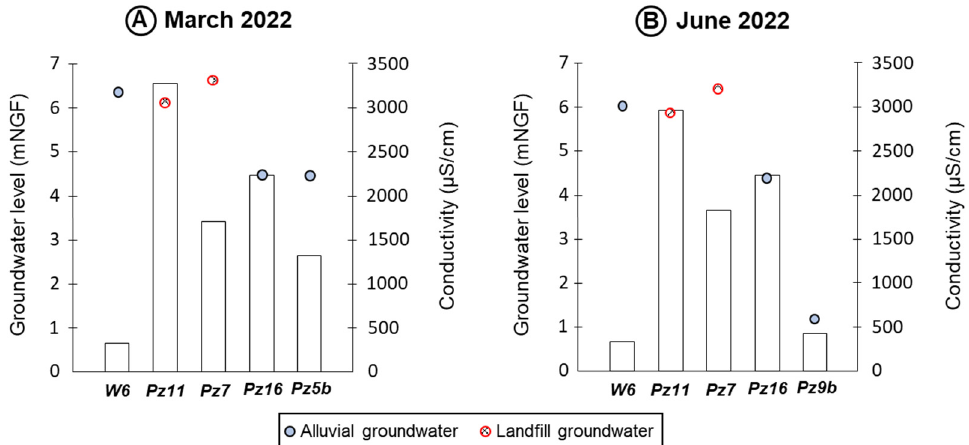
Figure 3. Water level (in m, dots) and conductivity (in µ S/cm) at the different sampling points from upstream to downstream in ( A ) March and ( B ) June 2022. Water levels are represented according to their groundwater bodies (in blue for alluvial groundwater, in red for landfill groundwater).